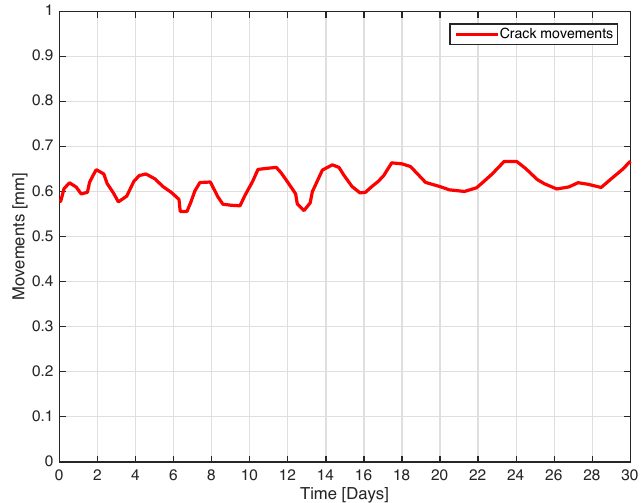
Figure 13. Crack movements vs. time. The tag placed in position A in the west side of the